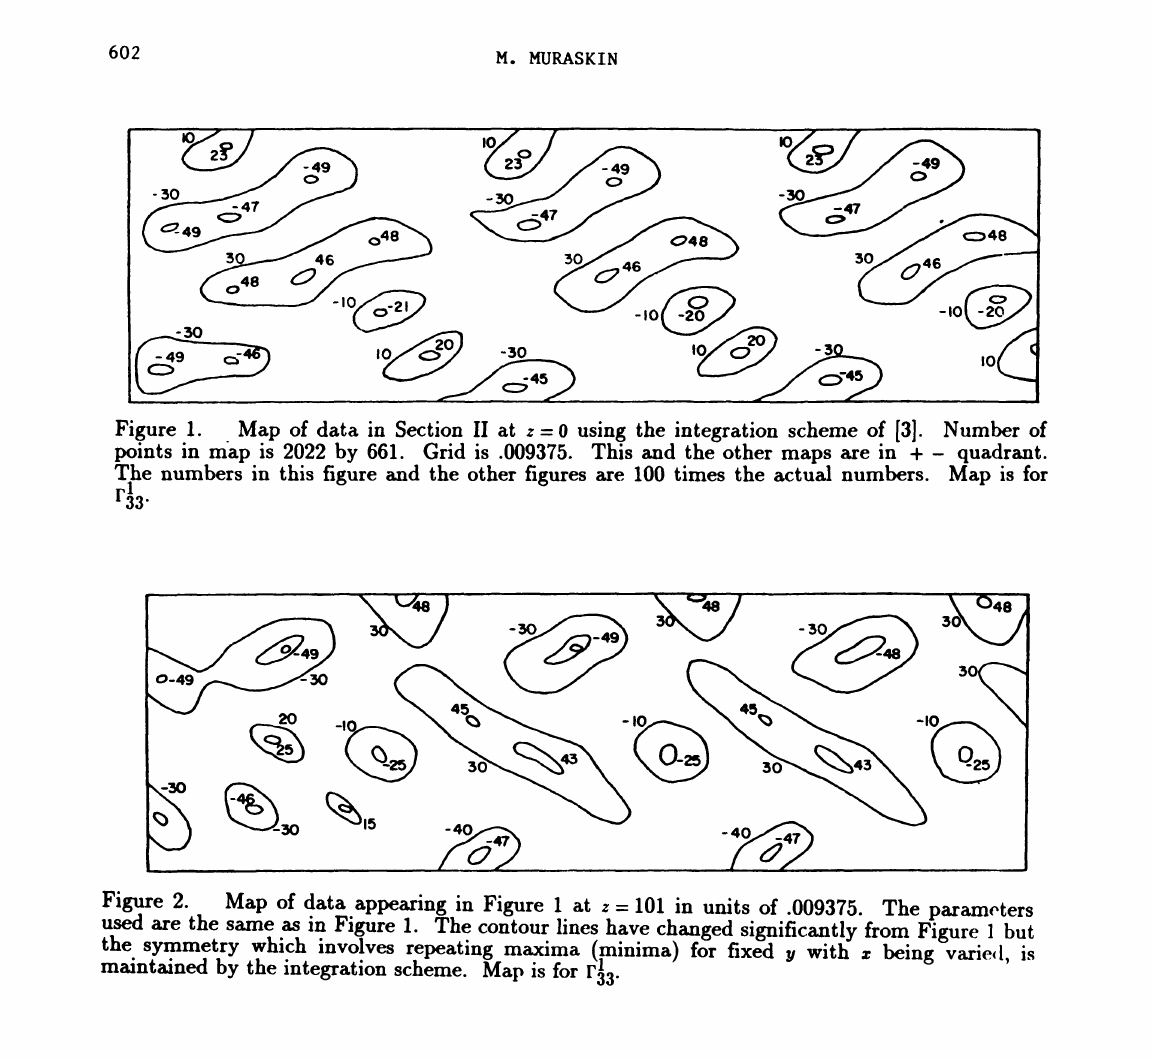
y with z being varie, l, is